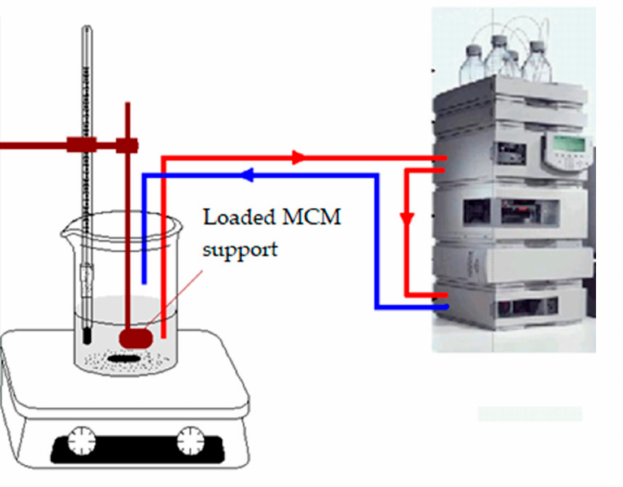
Figure 9. The experimental system (modified HPLC) used for the desorption profile